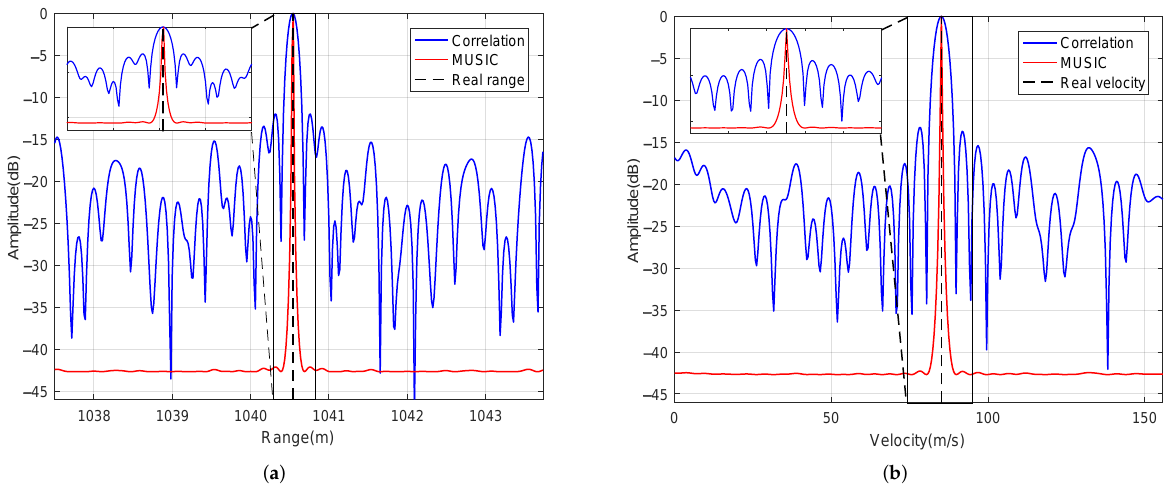
Figure 6. Range and velocity profiles ( a ) Range profile at 1040.54 m. ( b ) Velocity profile at 85.2 m/s.